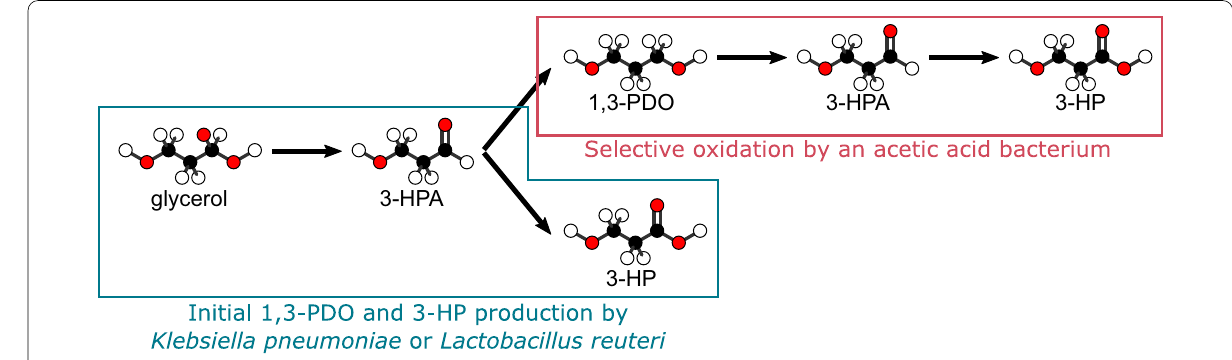
Fig. 1 Schematic representation of the metabolic pathway for 3‑HP production from